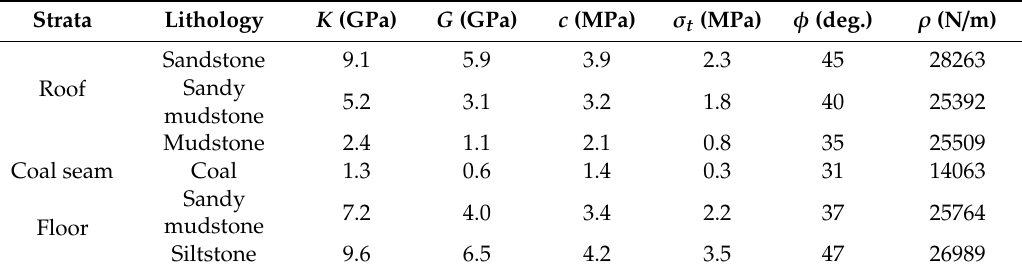
Figure 5. Flowchart of the numerical modeling approach for longwall mining. Table 1. Rock mass mechanical properties b.